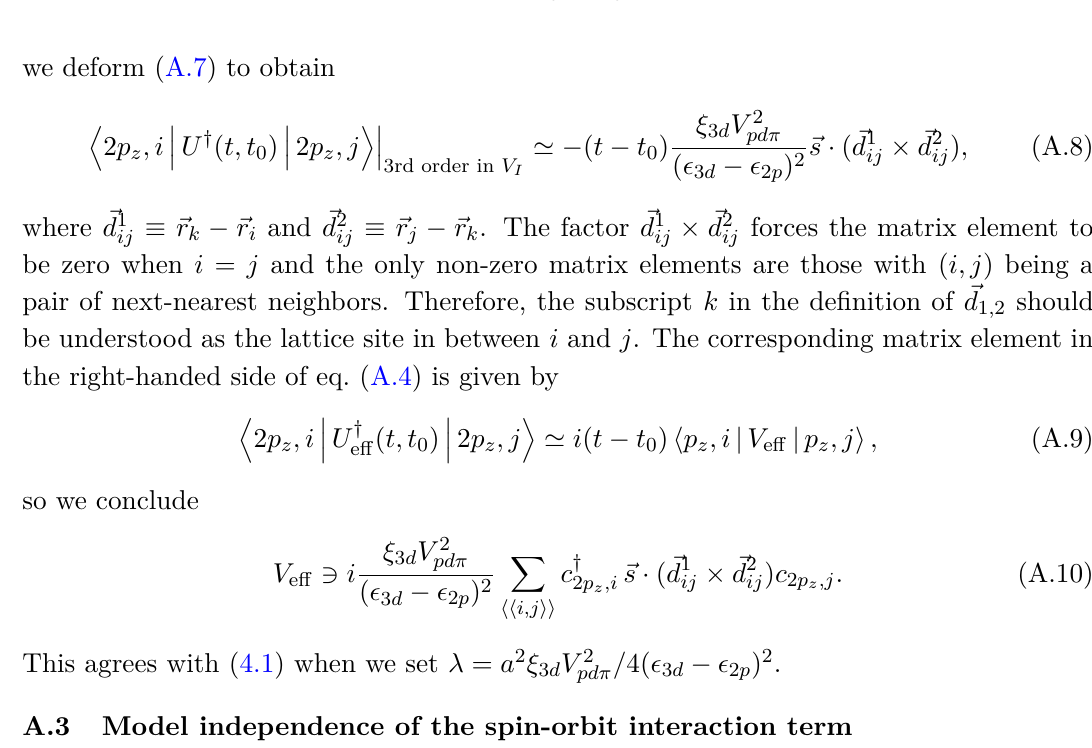
Figure 3 . The coordinate adopted in deriving the general form of the spin-orbit